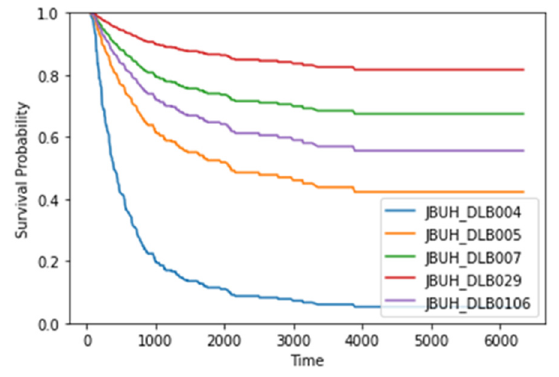
survival times in the range of 527–2421 days.